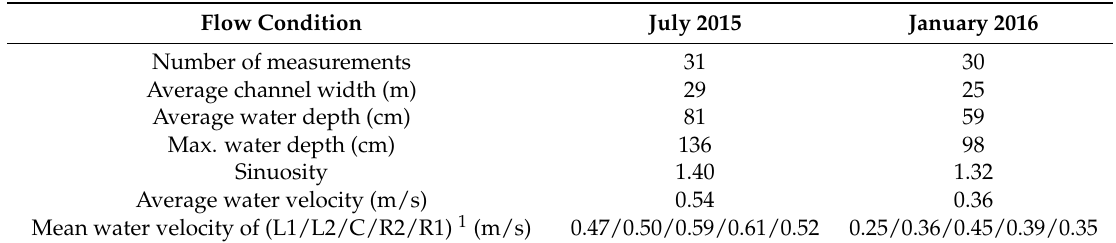
Table 1. Flow conditions at the channel bend of the Beiluo River during July 2015 and January 2016. Flow